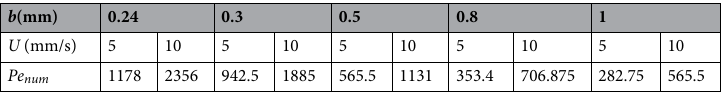
Table 2. Values of Pe num for numerical simulations.